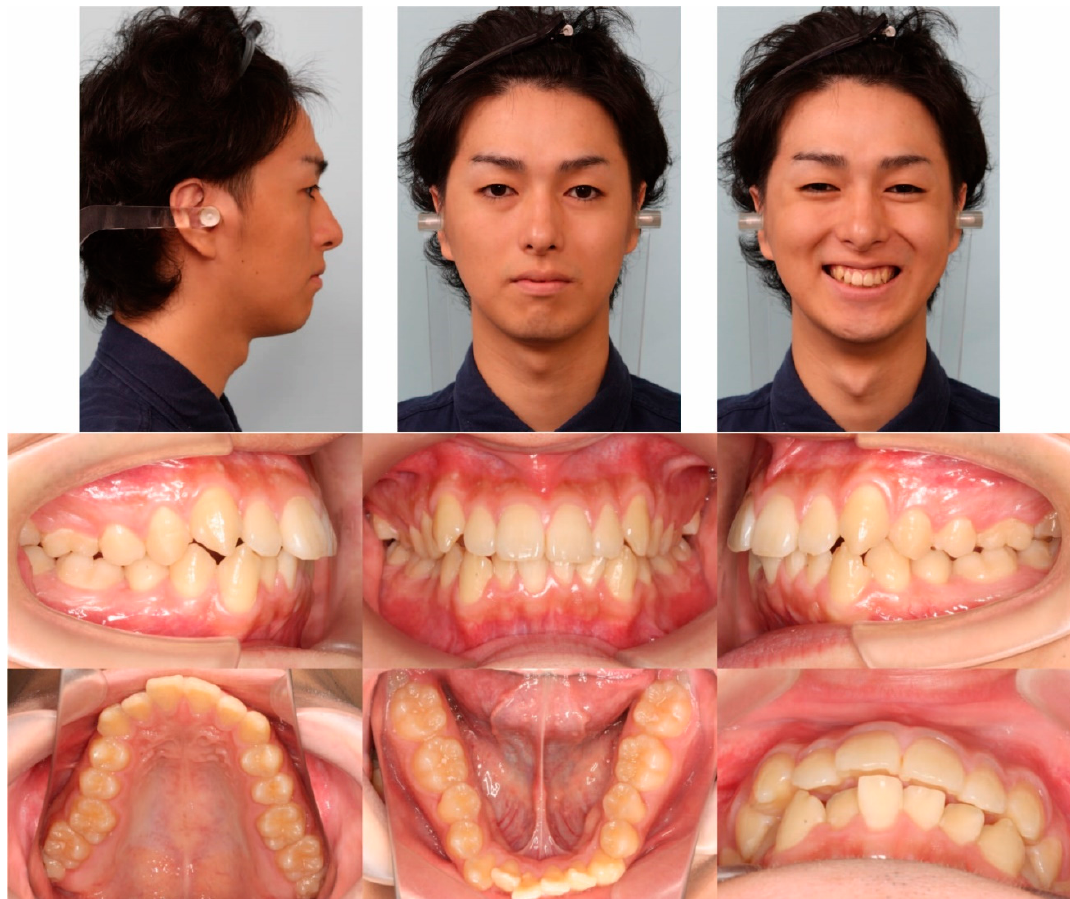
Figure 1. Pretreatment facial and intraoral photographs.